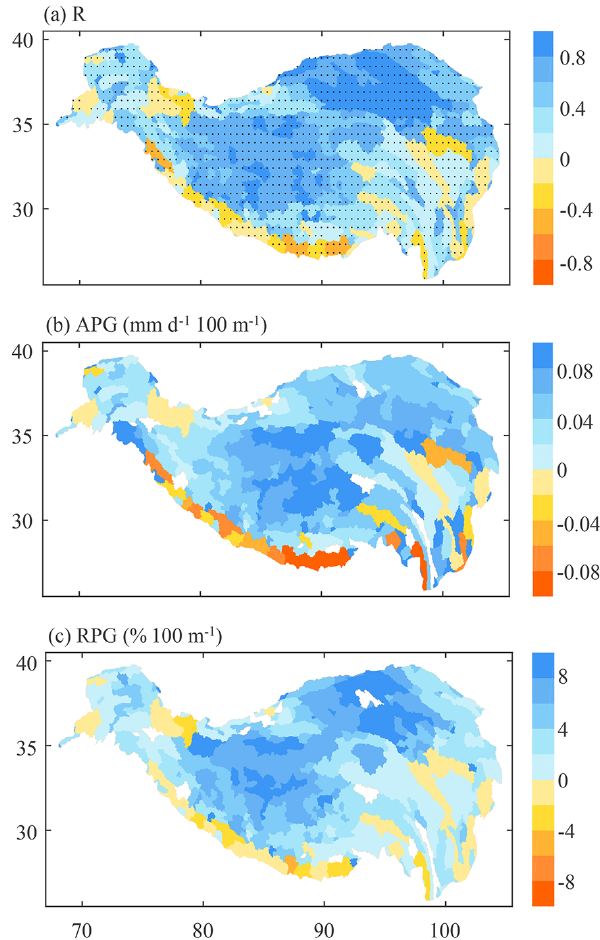
Figure 3. Spatial distribution of (a) correlations between the annual average precipitation and altitude for all grids within each basin, (b) absolute precipitation gradients (APGs, precipitation change per 100m altitude difference) and (c) relative precipitation gradients (RPGs, APGs divided by basin-average precipitation). The APGs and RPGs are calculated based on annual precipitation averaged from 1980 to 2018. The dots in Fig. 3a represent the correlations significant at the 95% confidence level. In Fig. 3b and c, the sub- basins with weak relationships between precipitation and altitude or no data value of RPG are filled with